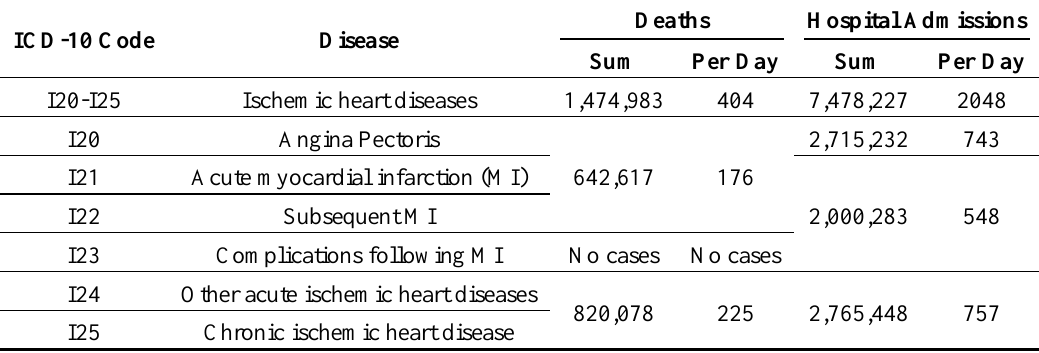
Table 1. Total numbers and daily averages of deaths and hospital admissions due to I20-I25 and the sum of I20 to I25 are caused by data privacy protection reasons: if the Research Data Centre of the Statistical Offices of the